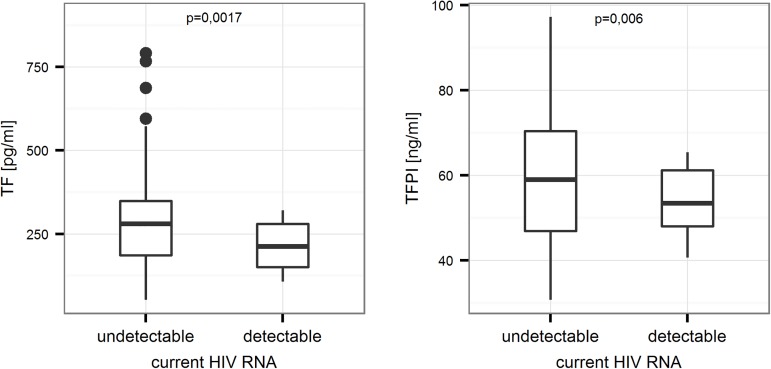
Comparison of concentrations of TF and TFPI between patients with detectable and undetectable levels of HIV RNA in the study group (p = 0.0017 and p = 0.006, respectively).Mann-Whitney test.